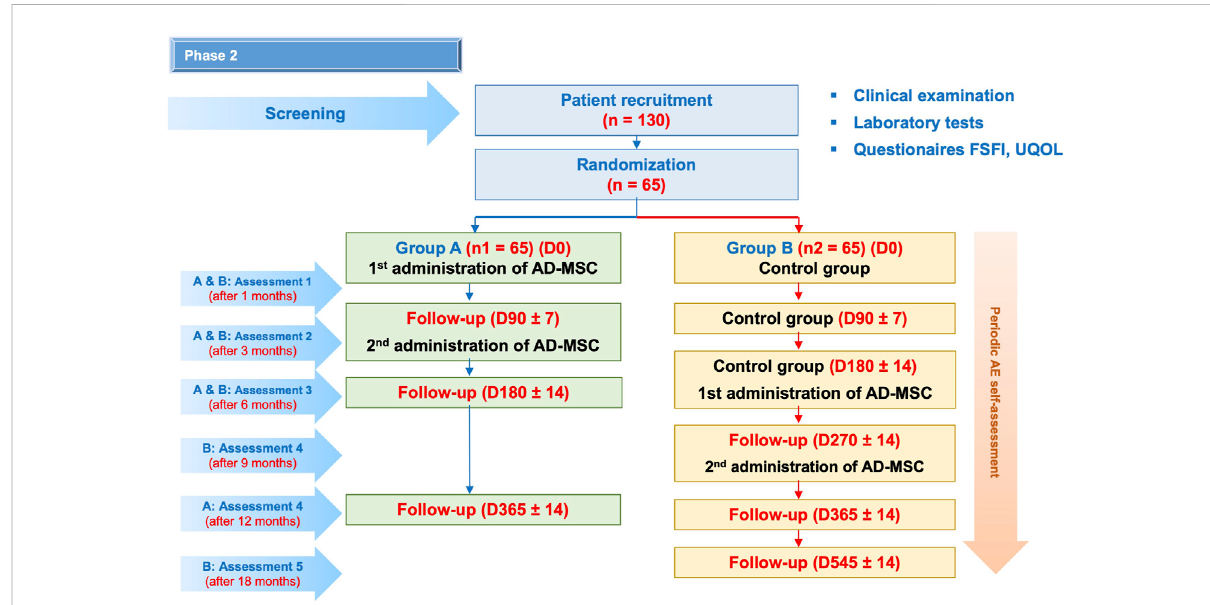
FIGURE 3 Research diagram. A total of 130 enrolled patients will be randomly assigned to two groups: group A will receive two infusions of autologous ASCs at day 0 and day 90 ± 7; group B will receive two infusions of autologous ASCs at day 180 ± 14 and day 270 ± 14. All patients will be monitored for 12 months after the fi rst cell infusion. During this period, AEs will be recorded every week after the ASC infusions and every month in the next months by the study team. Patient visit schedules are depicted, in which physical examination, laboratory tests and FSFI and UQOL questionnaires will be administered. Furthermore, cytokine pro fi les will be analyzed at baseline and on days 30 ± 2, 90 ± 7, and 180 ± 14. Cellular aging biomarkers will be quanti fi ed at baseline and at 180 ± 14 and 365 ±